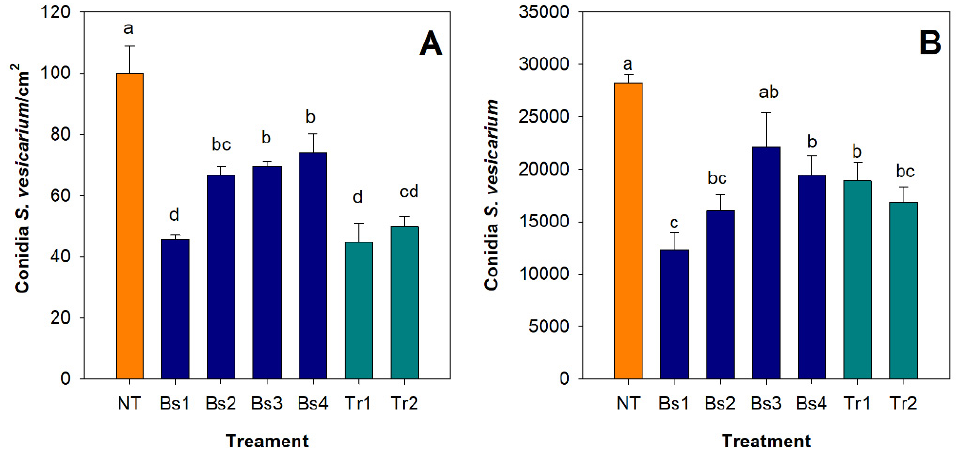
Figure 5. Total conidia of Stemphylium vesicarium trapped in trial 1 ( A ) and 2 ( B ), under orchard conditions. Conidia were trapped with mechanical spore-traps ( A ) or rain-catch traps ( B ). In trial 1 ( A ) total conidia S. vesicarium /cm 2 is shown whereas in trial 2 ( B ) the total of conidia caught through- out the trial period is shown. Biological control agents used were Bacillus subtilis strains (Bs1, Bs2, Bs3, Bs4) and Trichoderma spp. strains (Tr1, Tr2). NT: non-treated control. Results shown are